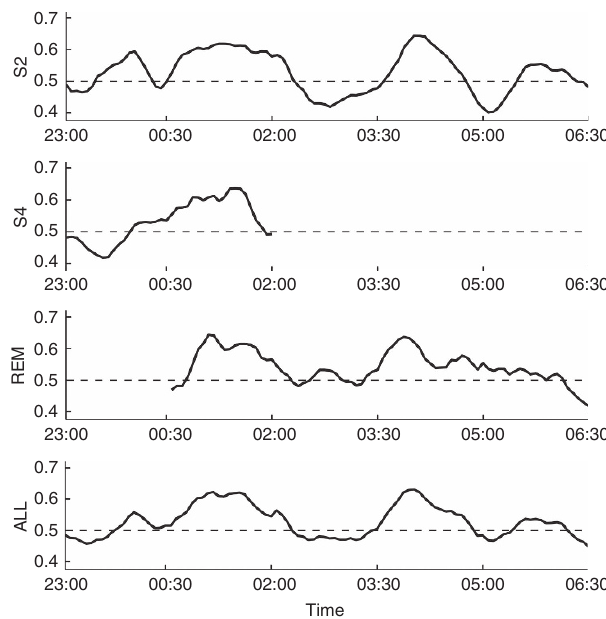
Figure 4 | Time course of classification accuracy across the night. Separate analyses were performed for sleep stages S2, S4 and REM sleep. Classification performance follows an oscillatory pattern and peaks around 3 and 6h after learning in all stages. Timing therefore is more relevant to when memory reprocessing occurs than sleep